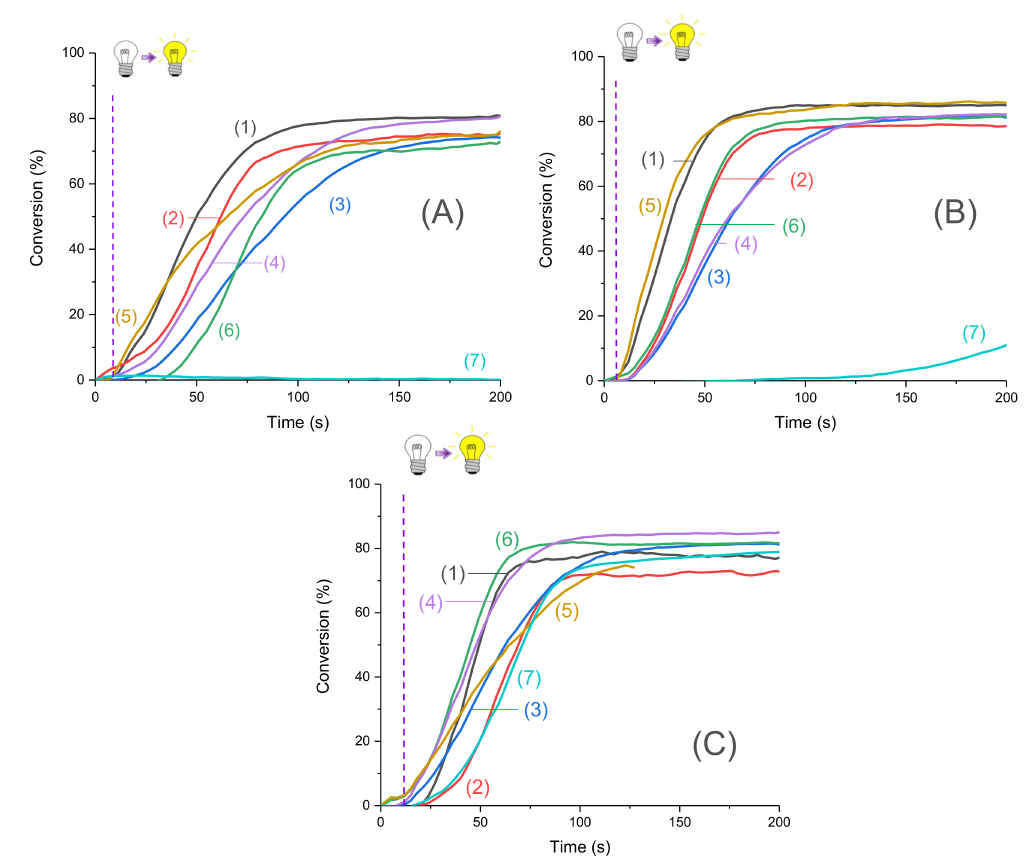
Figure 3. Photopolymerization profiles of Mix-MA under air (methacrylates function conversion vs. irradiation time) in the presence of (1)–(6) / Ar 2 I + PF 6 − (3 wt%) / 4-dppba (2 w%) with: (1)